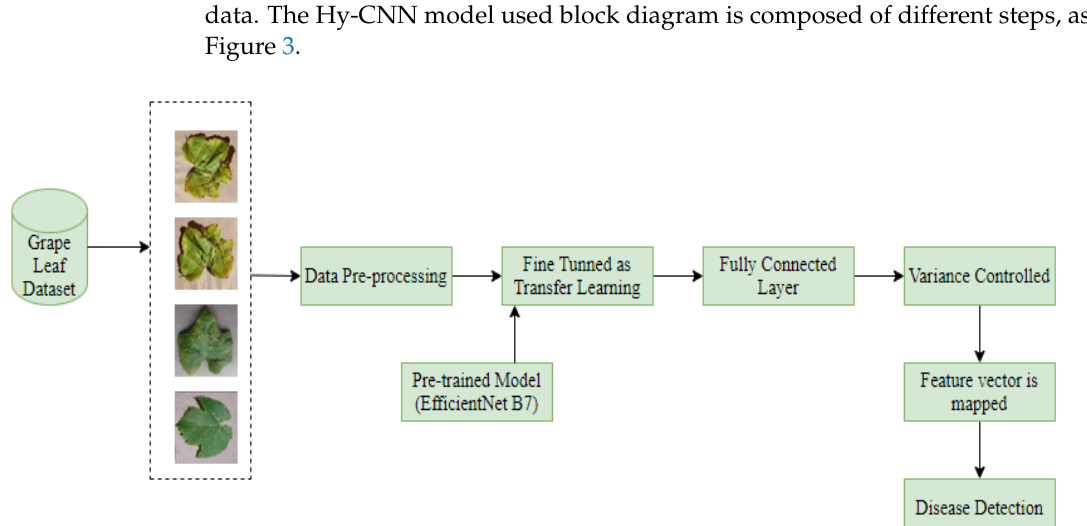
Figure 3. Hy-CNN model block diagram for grape leaf disease detection and classification.